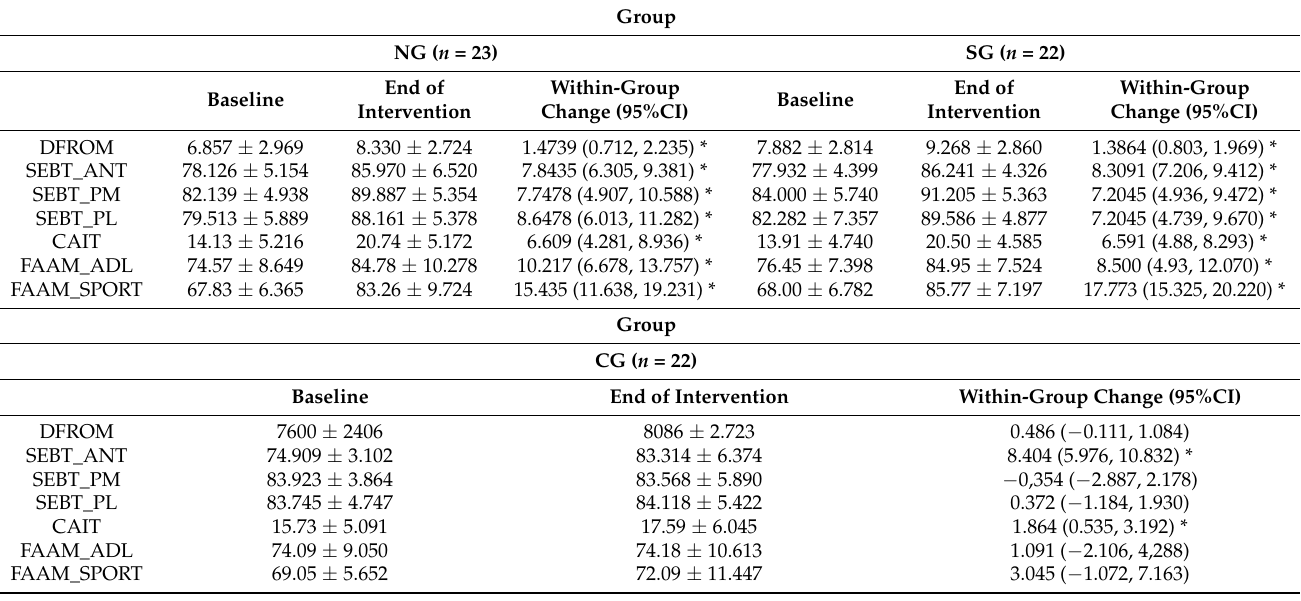
Table 2. Within-Group Change Scores Between Pre- and Postintervention Measurements.